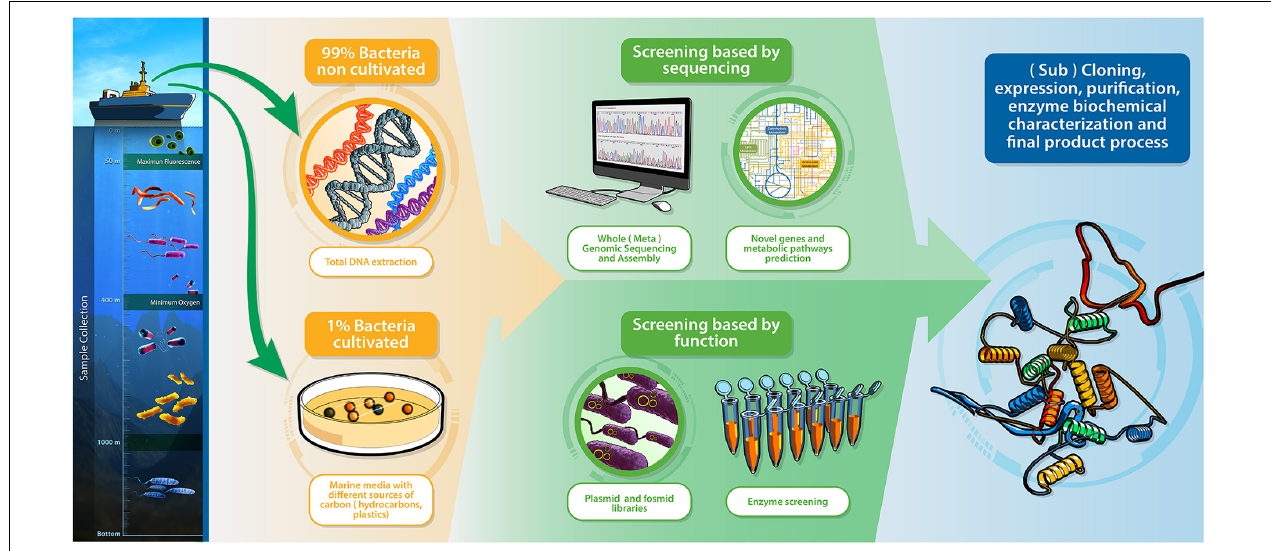
FIGURE 8 | Metagenomics as a tool for enzyme discovery. Overview of screening by sequence and